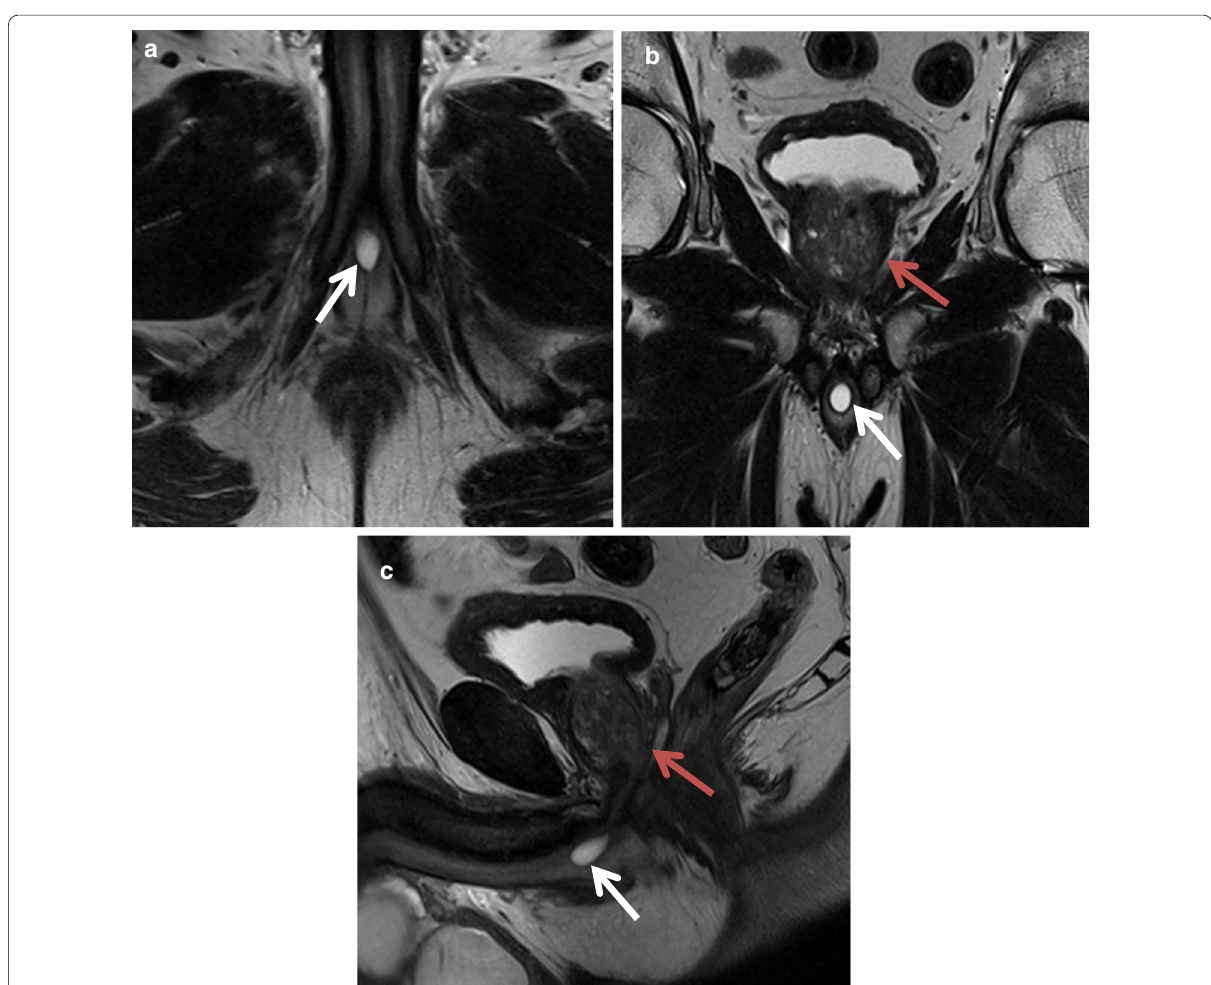
Fig. 5 Cowper’s gland duct cyst a Axial, ( b ) coronal and ( c ) sagittal T2 weighted images show a midline ovoid high T2 signal lesion at the penile base (white arrow) in keeping with a Cowper’s gland duct cyst. The prostate is seen superior to the lesion (red